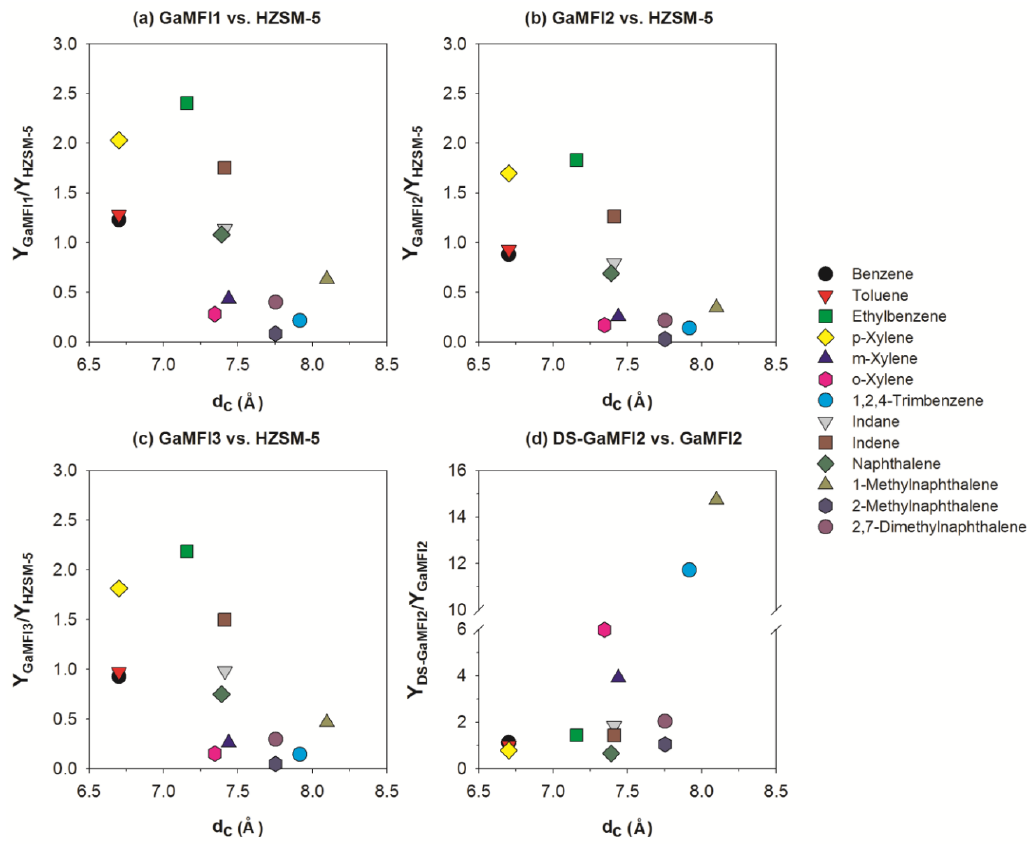
Figure 5. The ratio between the yield of aromatics in CFP of beech wood with HZSM-5 and Ga-containing MFI zeolites as a function of the molecular size of the aromatics. ( a ) GaMFI1 vs. HZSM-5; ( b ) GaMFI2 vs. HZSM-5; ( c ) GaMFI3 vs. HZSM-5; ( d ) DS-GaMFI2 vs. GaMFI2.